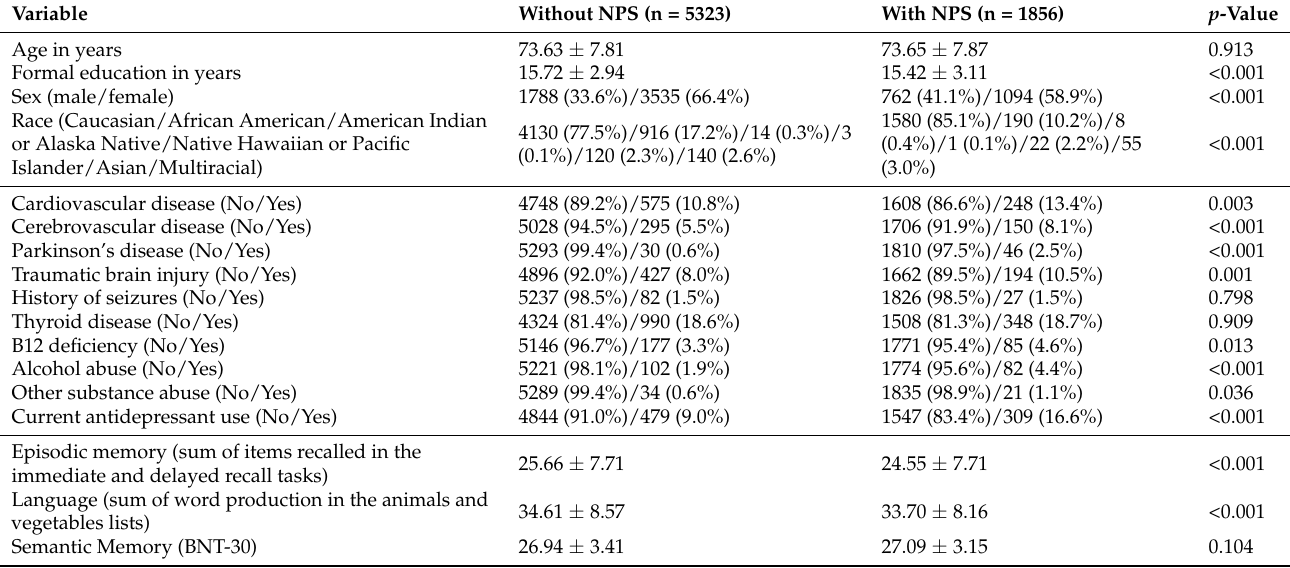
Table 1. Baseline differences between cognitively unimpaired individuals without and with one or more neuropsychiatric